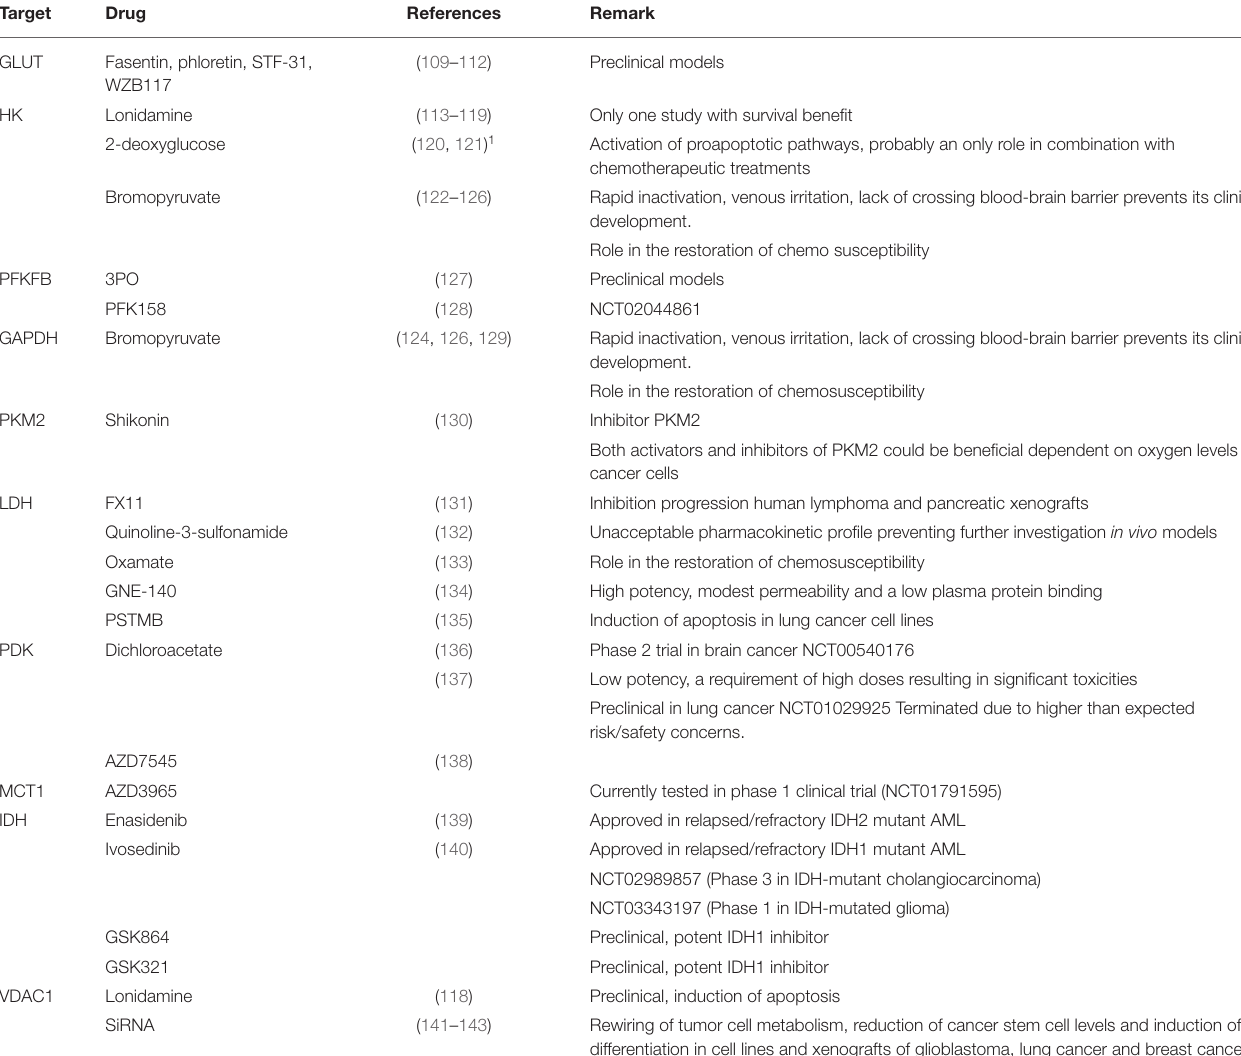
TABLE 1 | Some inhibitors of glycolytic enzymes and transporters which are in (pre)clinical development.